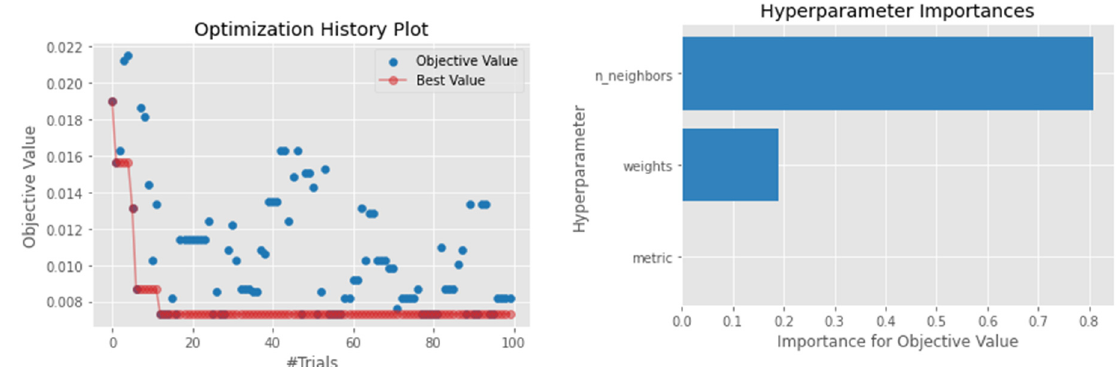
Figure 7. Hyperparameter optimization for the KNN model.